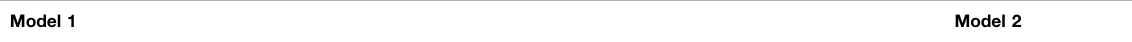
TABLE 2 | Boundary conditions used for FE